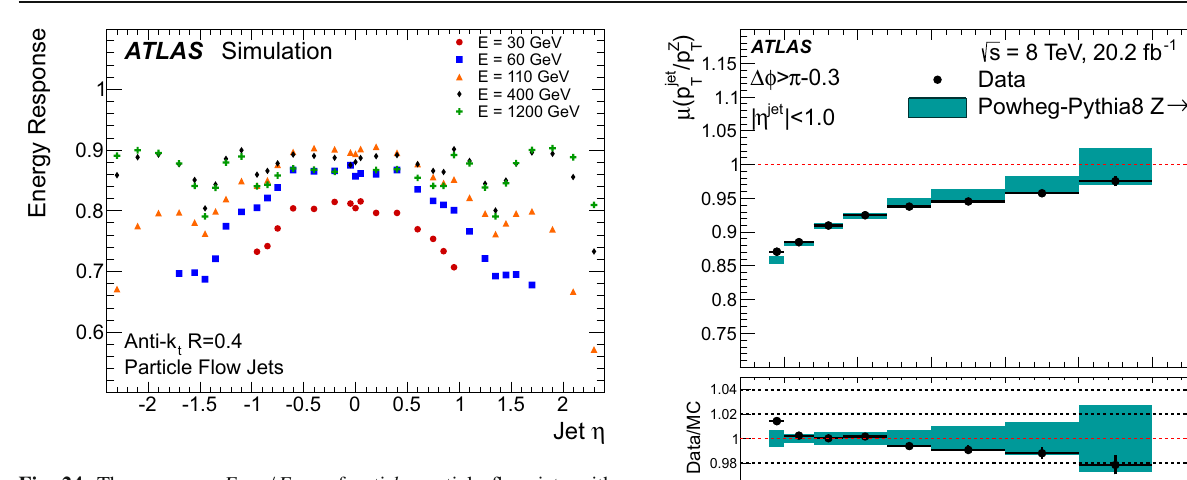
Fig. 24 The response E reco / E true of anti- k t particle flow jets with radius parameter 0.4 from MC dijet samples with no pile-up, as a func- tion of the jet η , measured prior to calibration, and binned in the energy of the matched truth jet